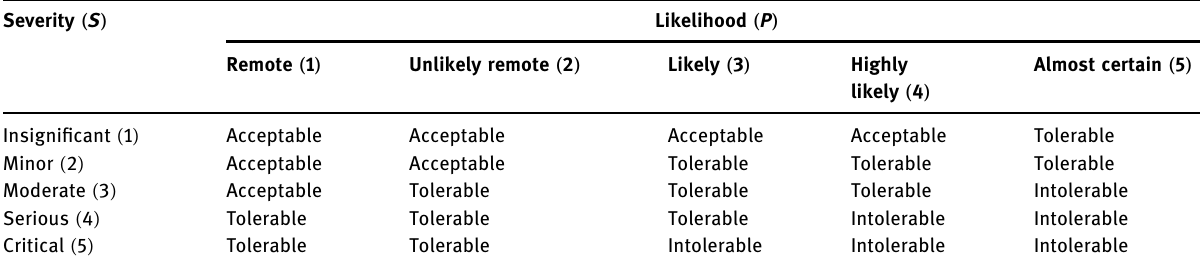
Table 2: Example of risk assessment decision matrix Severity ( S )